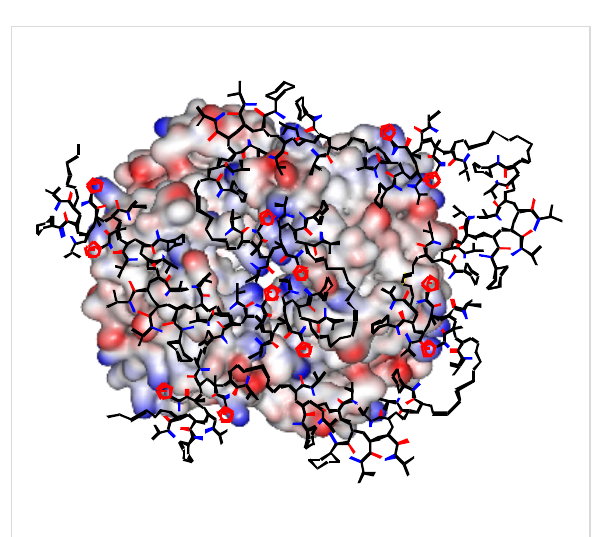
K d of 1 mM. With respect to varying pI values, both